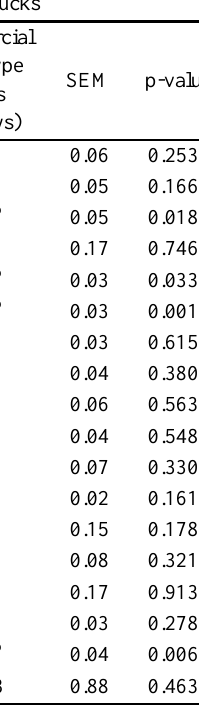
Table 6. Amino acid composition of the breast meat from Korean